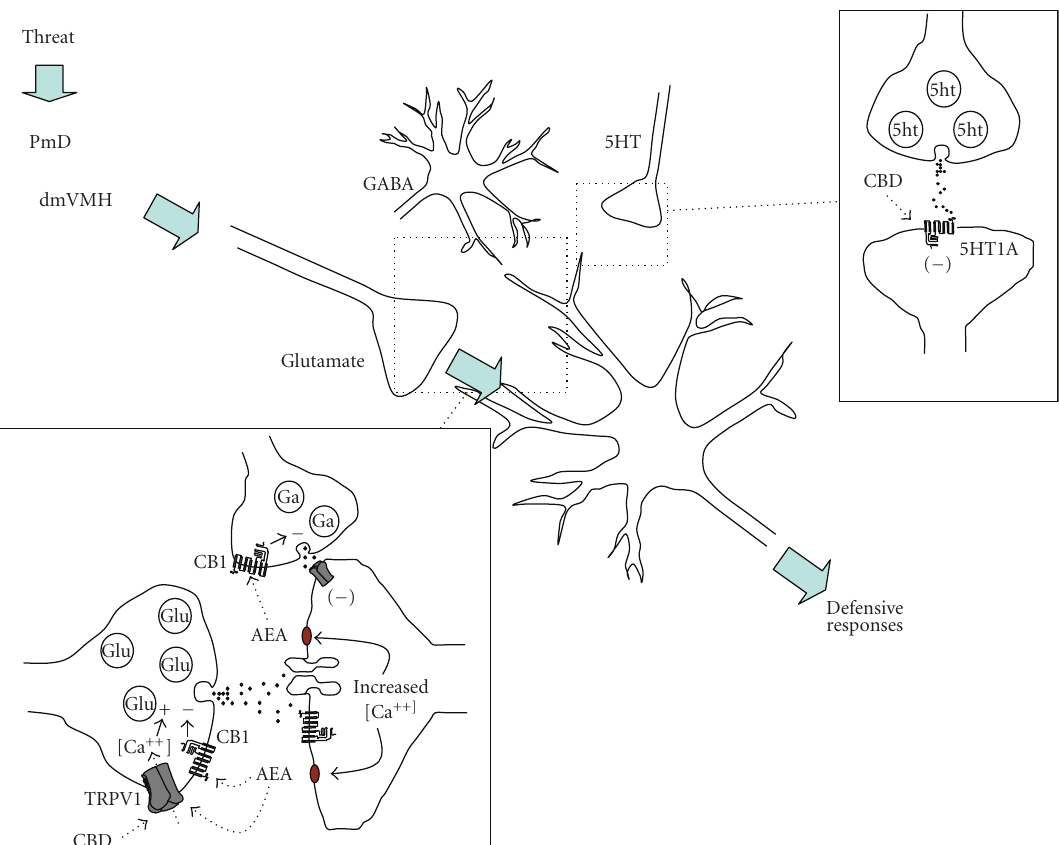
Figure 1: Possible e ff ects of cannabinoids in the dlPAG. Glutamatergic inputs from forebrain structures such as the dorsomedial part of the ventromedial hypothalamic nucleus (dmVMH) and dorsal premammilary hypothalamic nucleus (PmD) activate a local neural substrate that mediates defensive responses [88]. This substrate is under GABAergic and serotonergic inhibitory influence [26]. Activation of CB1 receptors by cannabinoids such as AEA interferes with presynaptic glutamate (Glu) and GABA (Ga) neurotransmitter release. CB1-mediated decrease of glutamate release would promote anxiolytic-like e ff ects. Activation of TRPV1 presynaptic receptors, on the other hand, would produce opposite e ff ects. The anxiolytic e ff ects of cannabidiol (CBD), a nonpsychotomimetic cannabinoid, in the dlPAG are not mediated by CB1 receptors, but probably involve activation of postsynaptic 5HT1A receptors. The bell-shaped dose-response curves observed with AEA and CBD may depend on activation of TRPV1 receptors. Regarding AEA, a presynaptic decrease of GABA release could also be related to this e ff